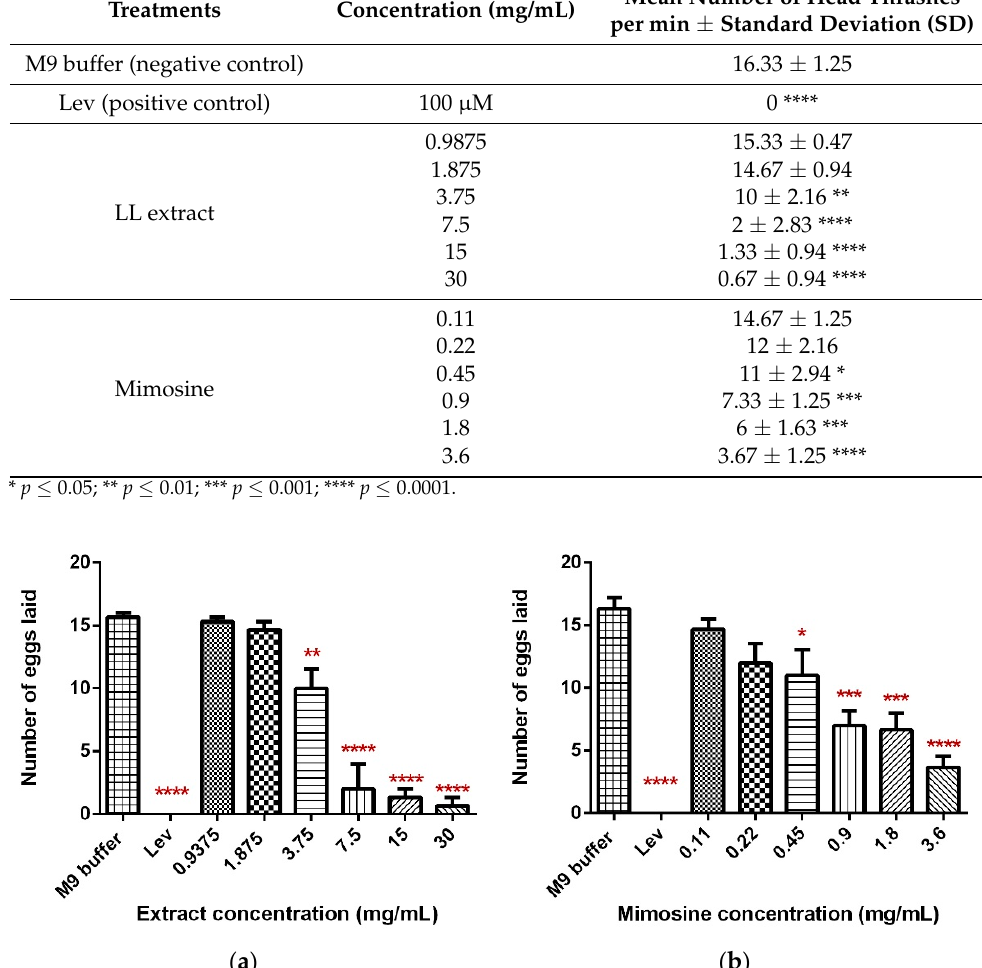
pharyngeal pumping activity in LL extract and mimosine are presented in Figures 8 and 9, respectively, and in Table